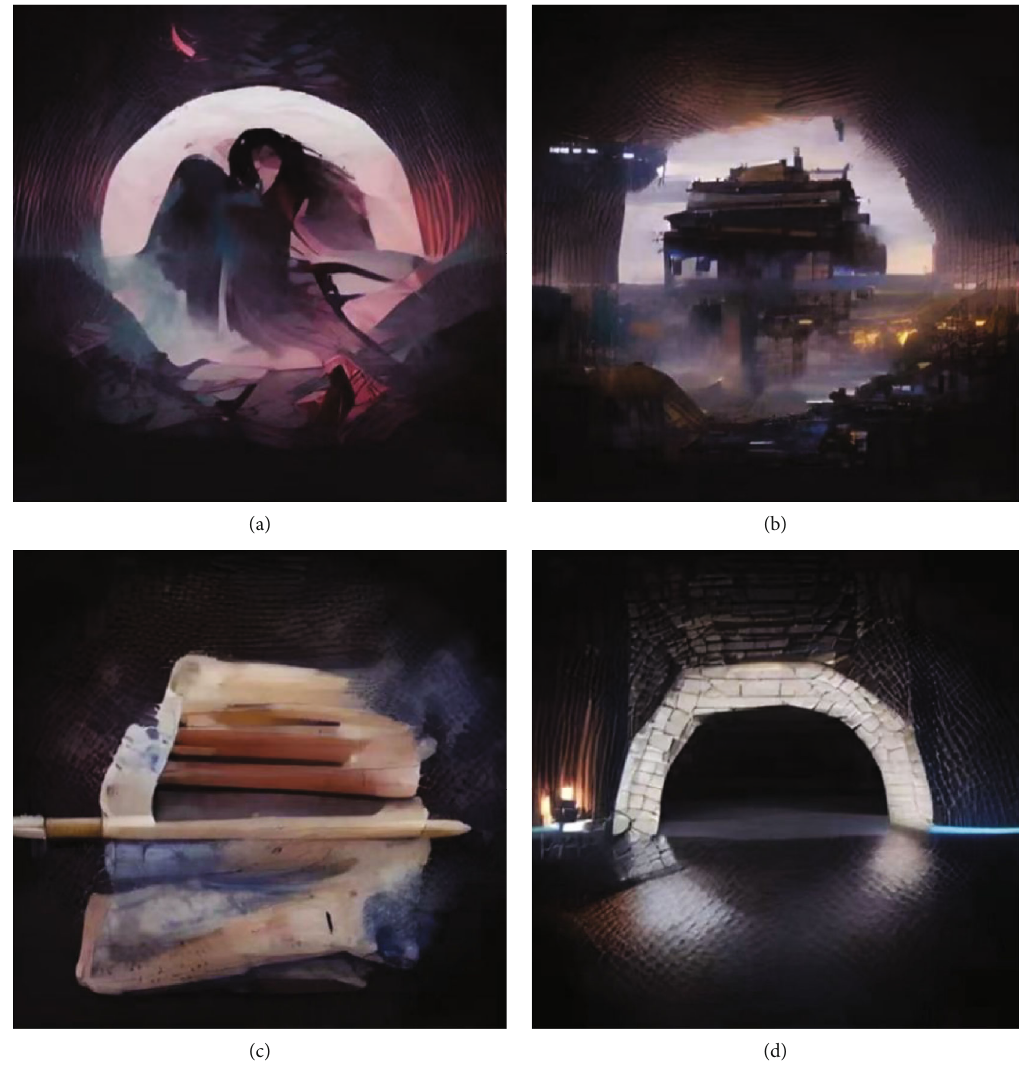
Figure 9: Four digital art paintings drawn with a circle as the artistic creation concept using big data fusion media